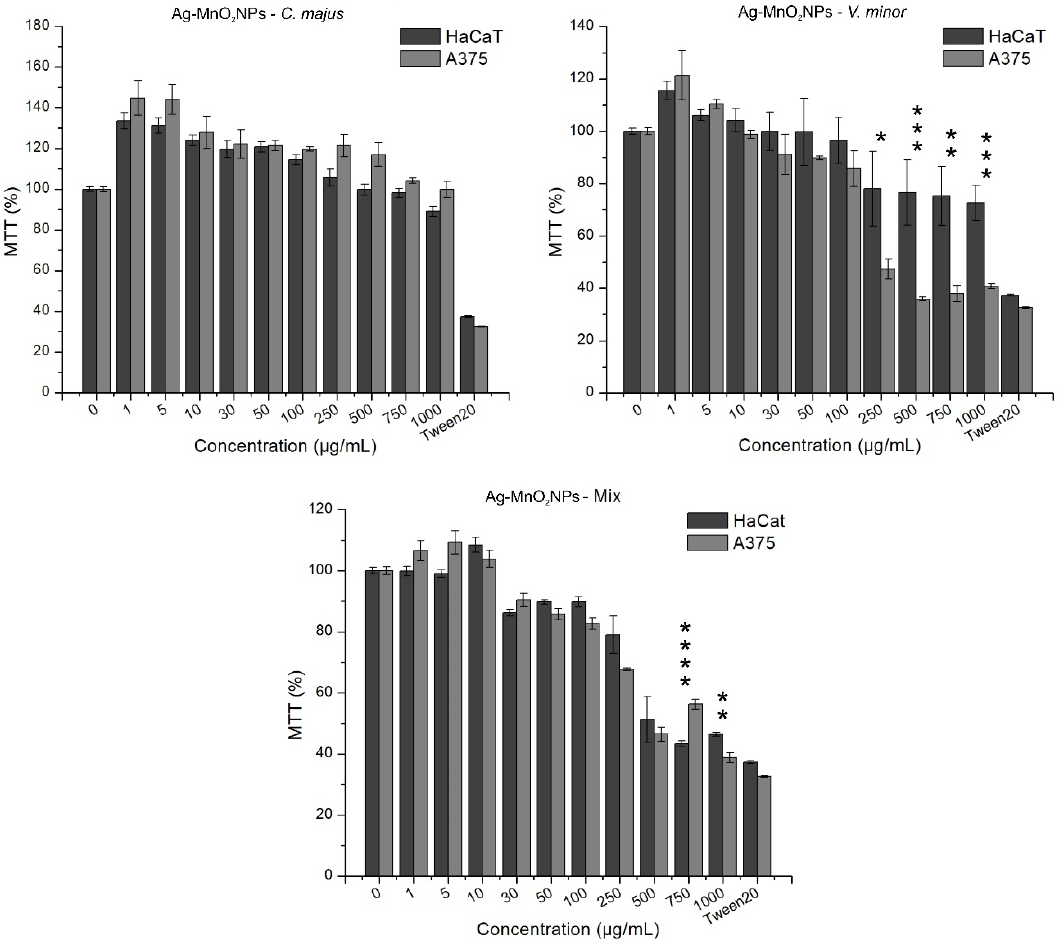
Figure 6. In vitro cytotoxic effect of green synthesized Ag-MnO 2 NPs on normal keratinocytes (HaCaT) and skin melanoma (A375) compared to a positive control (untreated cells) and a negative control (cells treated with 2% Tween20); ****: p < 0.0001, ***: p < 0.005, **: p < 0.05, *: p < 0.1.